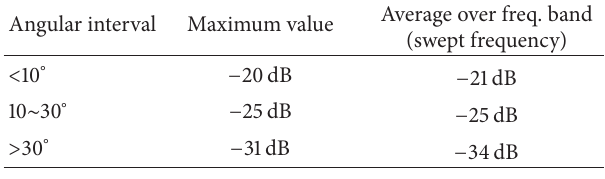
Angular interval Maximum value Average over freq. band